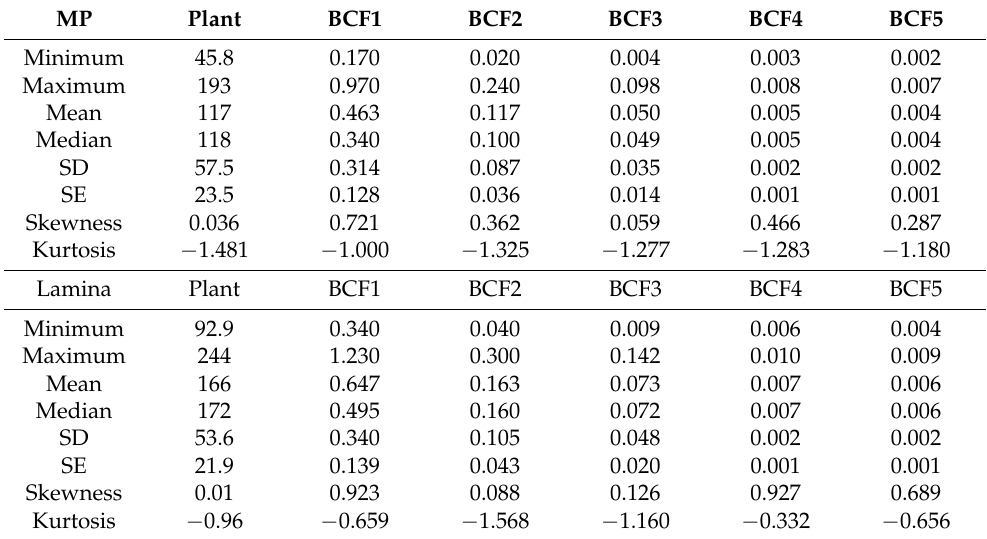
Table 10. Overall statistics of iron (Fe) concentrations (mg/kg dry weight) in the midrib plus petiole (MP), and lamina of Avicennia officinalis , and their bioconcentration factors (BCF) values, collected from 6 sampling sites in the mangrove areas of west coast of Peninsular Malaysia. MP Plant BCF1 BCF2 BCF3 BCF4 Minimum 45.8 Maximum 193